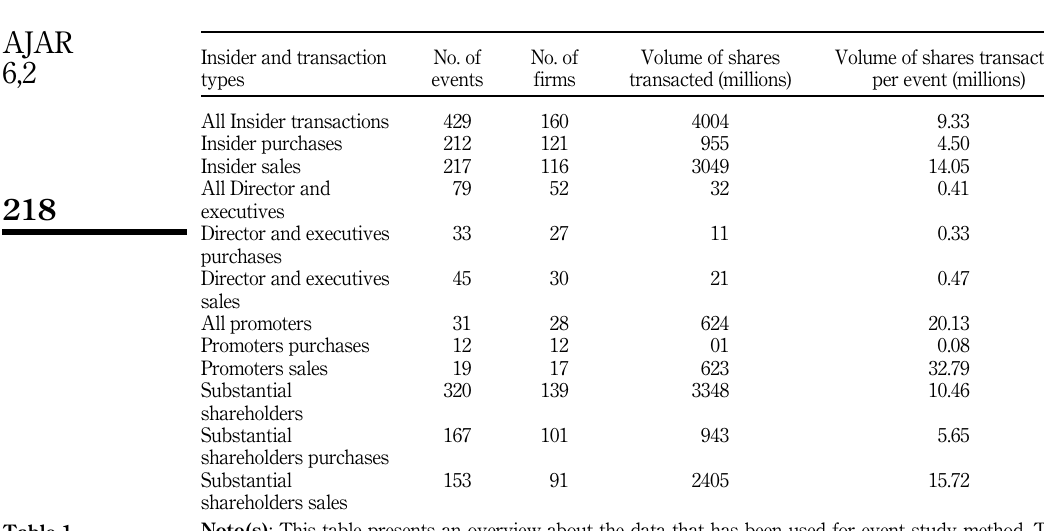
Table 1. Summary of event study